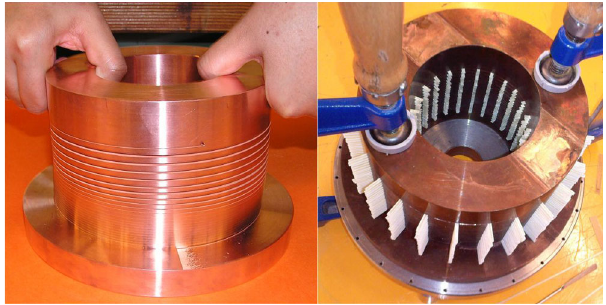
FIG. 28. Insertion of the prepreg insulators between the helix